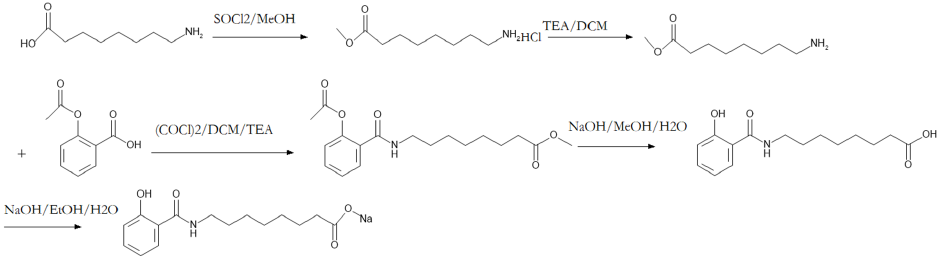
Figure 1. The synthesis process of N -[8-(2-hydroxybenzoyl)amino]caprylate (SNAC).